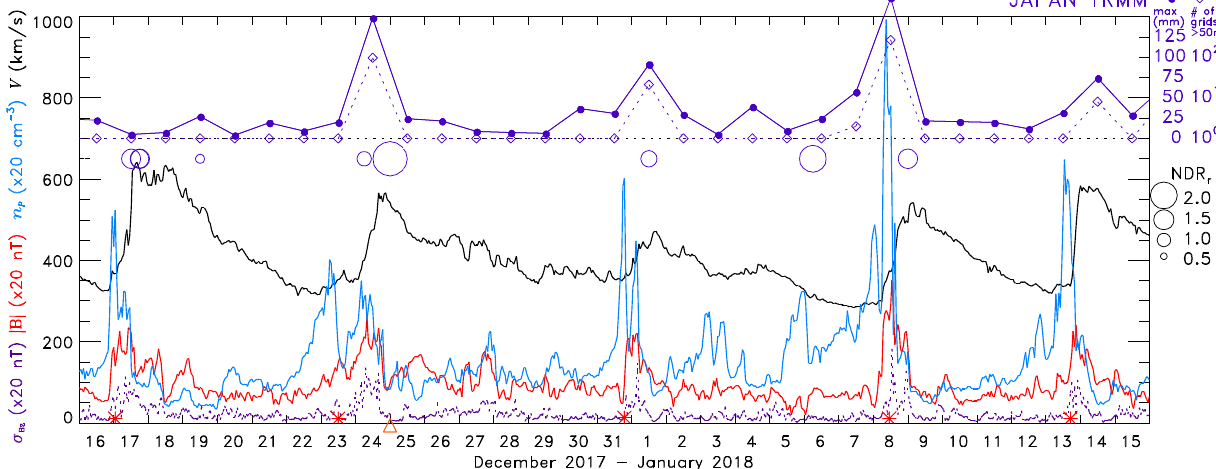
Figure 1. The OMNI solar wind V (solid black line), B (red), n p (light blue line) and σ Bz (dotted purple line) with the y -axis scales shown on the left. Major HSS/CIRs are marked by red asterisks and ICMEs by orange triangles at the time axis. At the top, maximum TRMM daily rates (solid blue line) and the number of TRMM grid cells over Japan with precipitation rates exceeding 50 mm (dotted line). Open circles scaled by the maximum normalized deepening rate of explosive extratropical cyclones over the North Pacific (120° E–230° E) are shown.